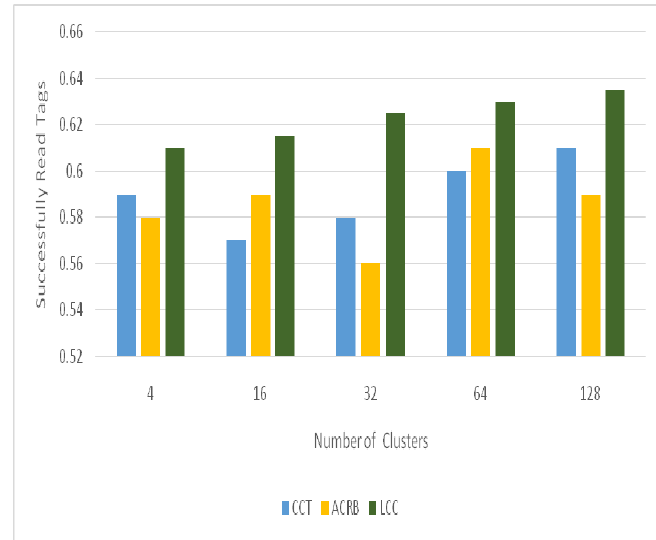
Figure 10. Successfully Read Tags vs. Number of